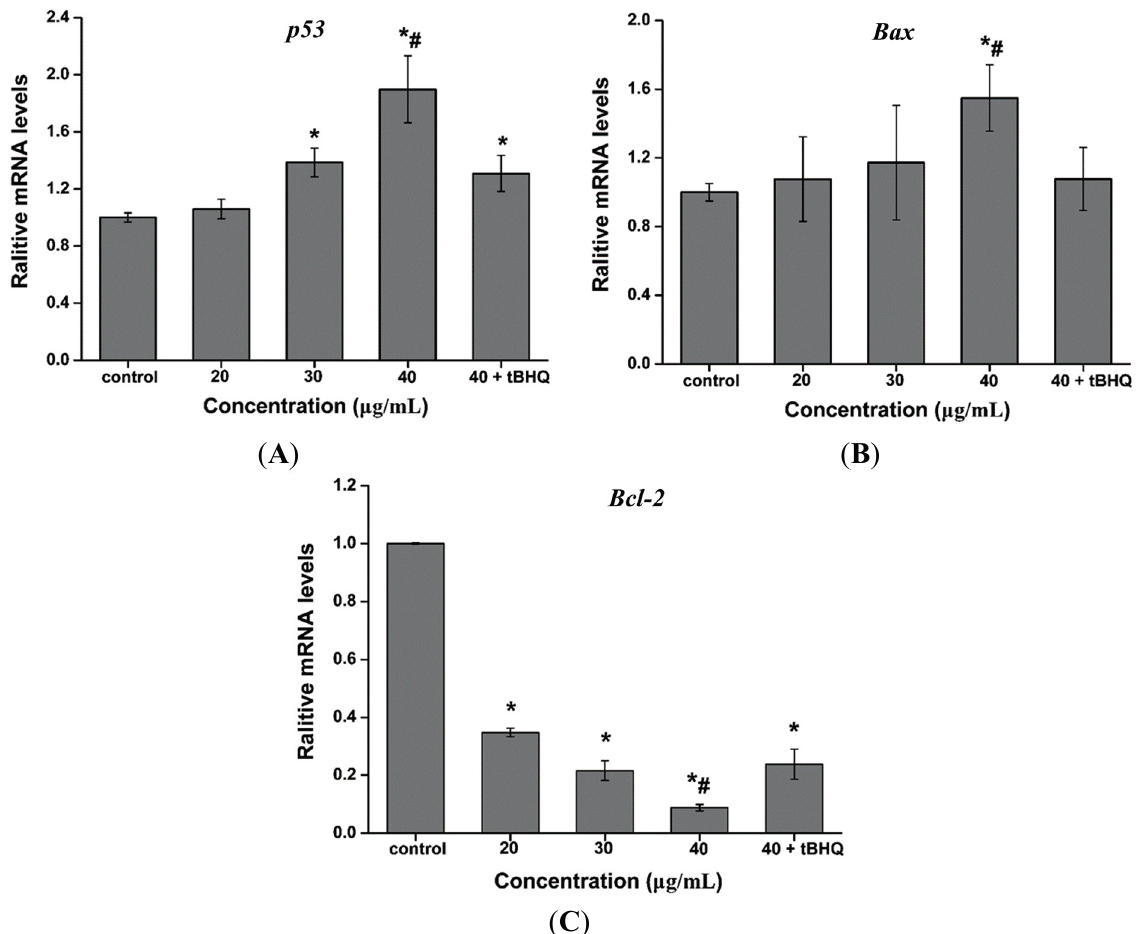
Figure 6. The mRNA expression levels of ( A ) p53 , ( B ) Bax and ( C ) Bcl-2 in AML 12 cells exposed to 20, 30, 40 μ g/mL CdTe QDs and (40 μ g/mL CdTe QDs + tBHQ) for 24 h. Data are presented as the mean ± SD from three independent experiments. The asterisks ( * ) and indicate statistically significant differences compared to control with p < 0.05,